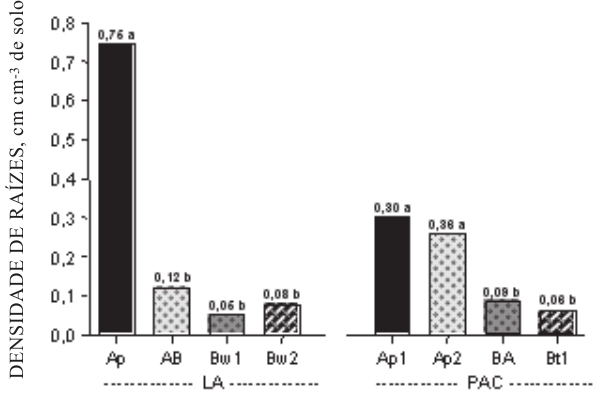
Figura 2. Densidade de raízes de citros em Latossolo Amarelo (LA) e Argissolo Acinzentado (PAC) de Tabuleiros Costeiros do Estado da Bahia. Médias seguidas pela mesma letra, para o mesmo solo, não diferem estatisticamente entre si, pelo teste de Scott-Knott a 5